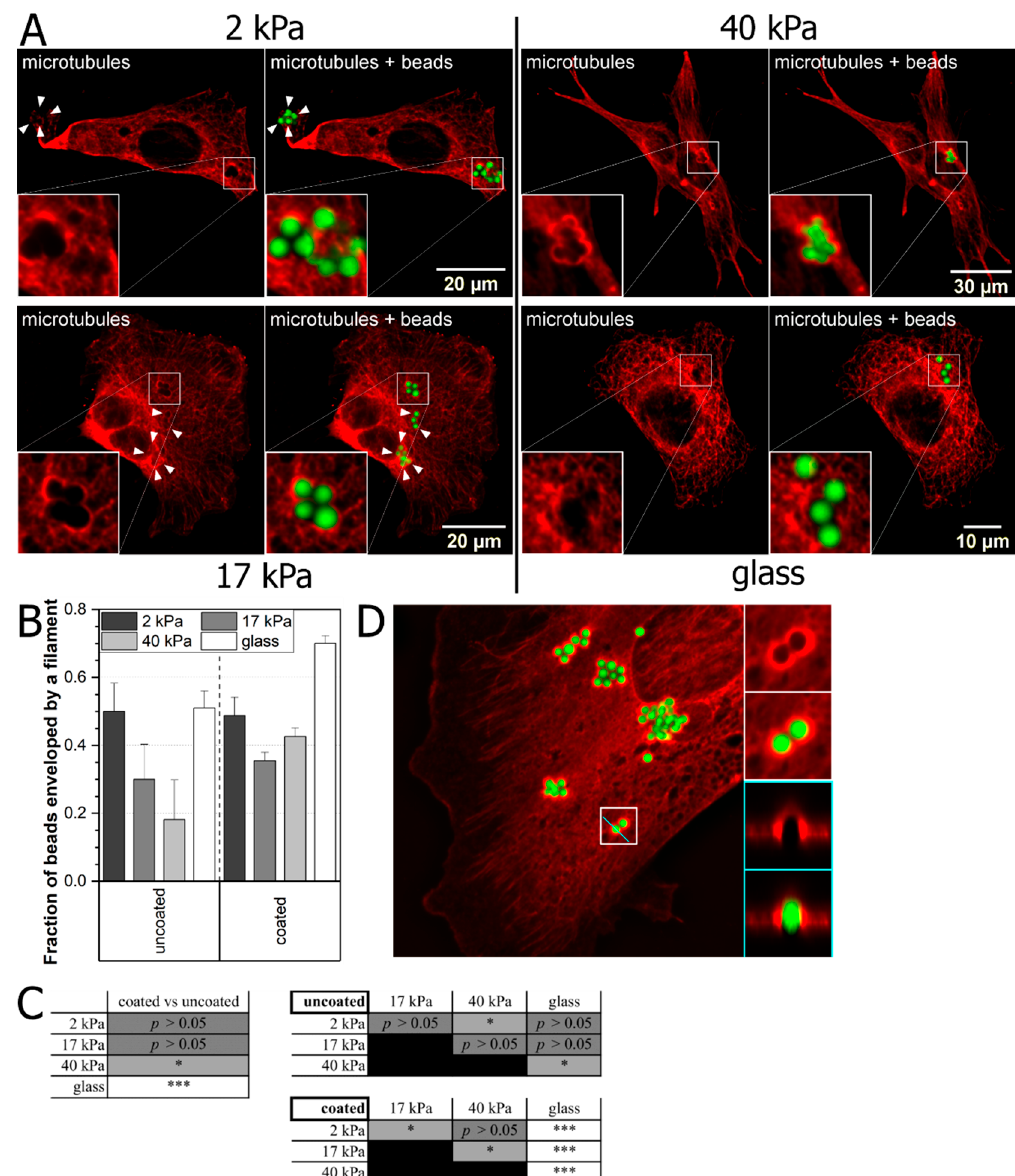
Figure 3. Influence of substrate elasticity on the latex bead-microtubule cytoskeleton interaction. ( A ) MEF cells were plated overnight on PA substrates of various elasticities or glass and incubated with 2 µ m latex beads (coated with fibronectin and uncoated) for 1 h, then fixed, stained for the microtubule cytoskeleton and imaged using confocal microscopy in 3D. Images are presented as sums of stacks. Arrows point at spots where beads were enveloped by microtubule filaments and visible changes could be observed. Representative images of examined elasticities for experiments with fibronectin-coated beads are shown. ( B ) Microtubules enveloped beads were counted and presented as fractions of all beads interacting with cells. Data are presented as a fraction ± SEM (2 kPa, uncoated, n = 36; 2 kPa, coated, n = 88; 17 kPa, uncoated, n = 20; 17 kPa, coated, n = 369; 40 kPa, uncoated, n = 11; 40 kPa, coated, n = 394; glass, uncoated, n = 100; glass, coated, n = 434). ( C ) Two proportion Z-test was used to determine statistical significance between specific samples: ( left ) uncoated versus coated beads; comparison between different substrate elasticities using uncoated ( upper right ) and coated beads ( lower right ). * p < 0.05, *** p < 0.001. ( D ) MEF cell plated on substrate of 17 kPa of elasticity, scanned as a 3D image and showed as a sum of stack. Green color represents beads, red—microtubules. On the right side an enlarged section (white frame) and an axial projection of the 3D image (cyan frame) are presented. Data are representative of at least two independent experiments. Our results show that more coated beads are enveloped in comparison to uncoated ones on stiffer substrates (40 kPa and glass). In the case of cells plated on soft